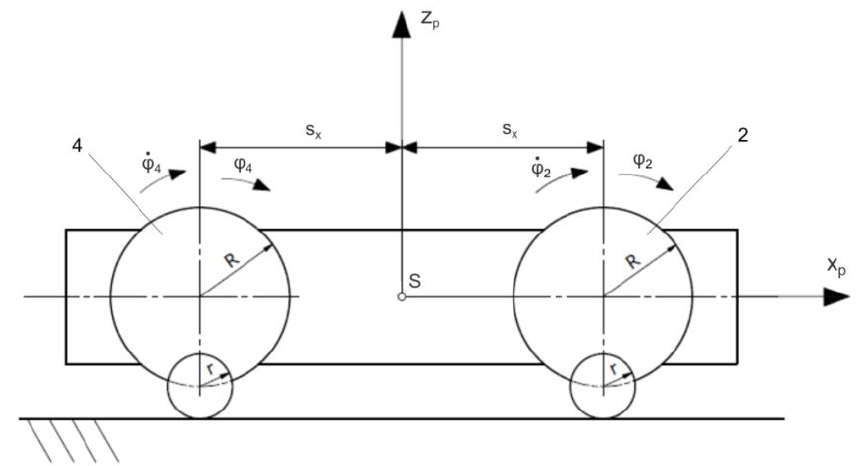
Figure 2. View of the WMR model in the x p z p plane .